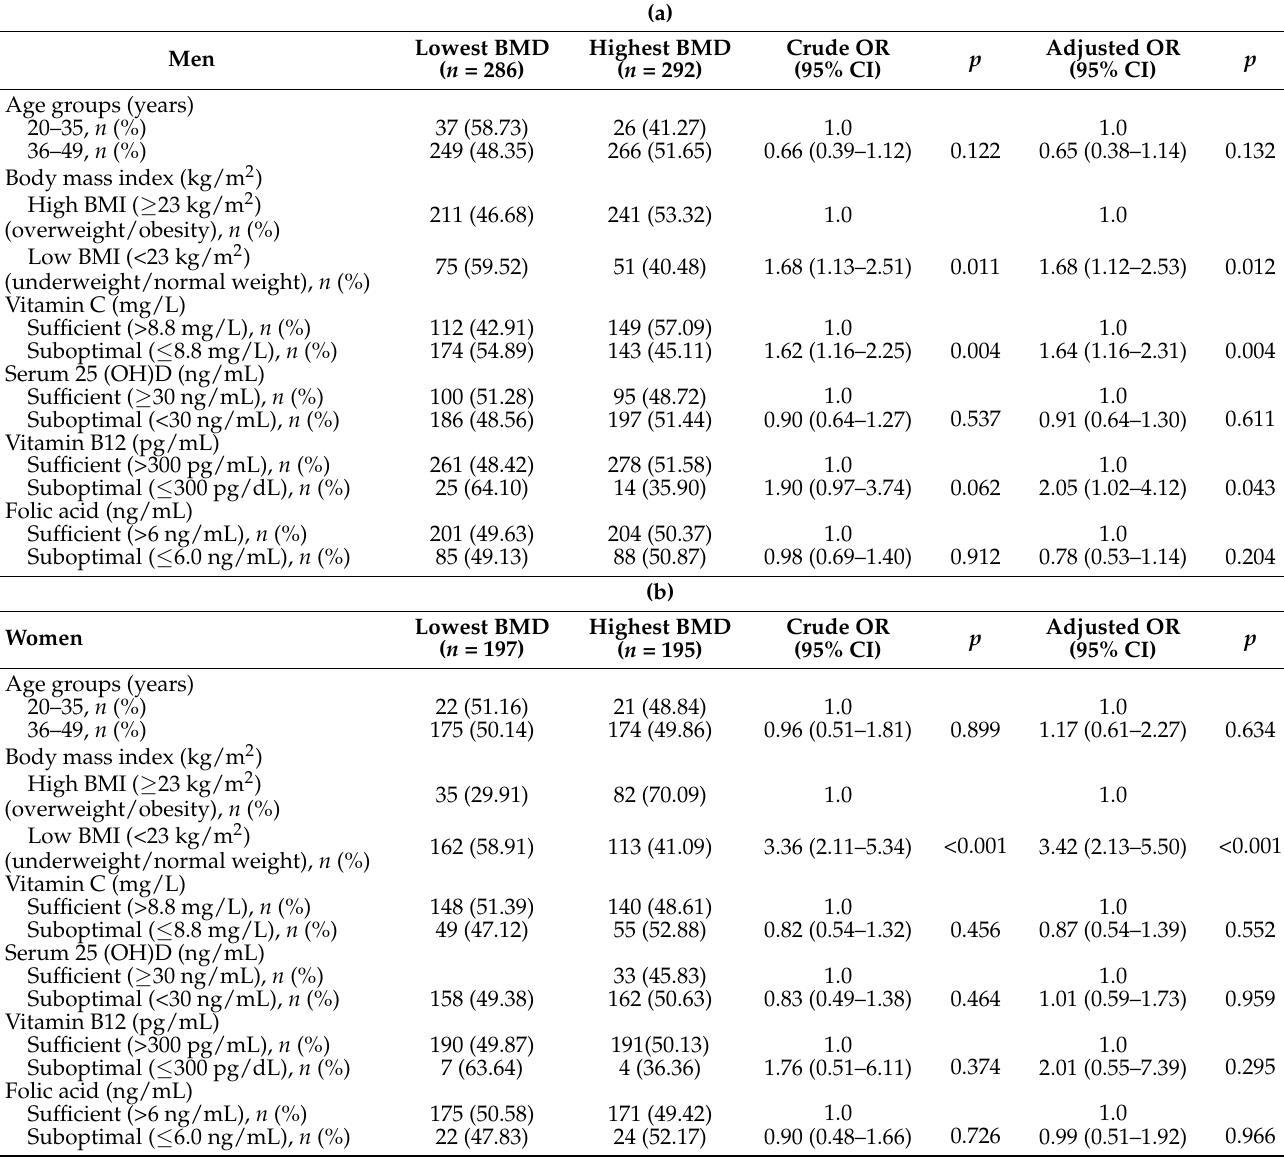
Table 4. ( a ) The correlations of the lumbar spine BMD status with age, BMI, and nutrients’ levels by the method of logistic regressions in men. ( b ) The correlations of the lumbar spine BMD status with age, BMI, and nutrients’ levels by the method of logistic regressions in